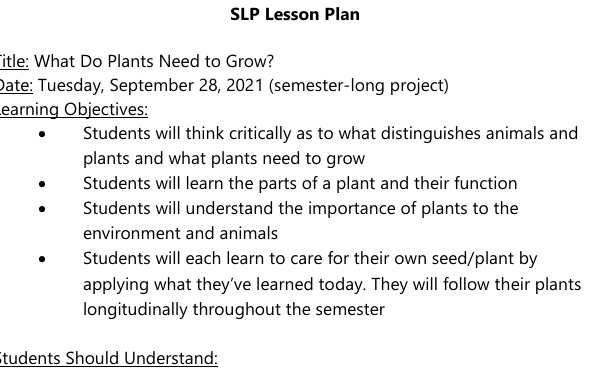
Figure 1 . An Example of One of The Formal Lesson Plans We Created for Each Session.